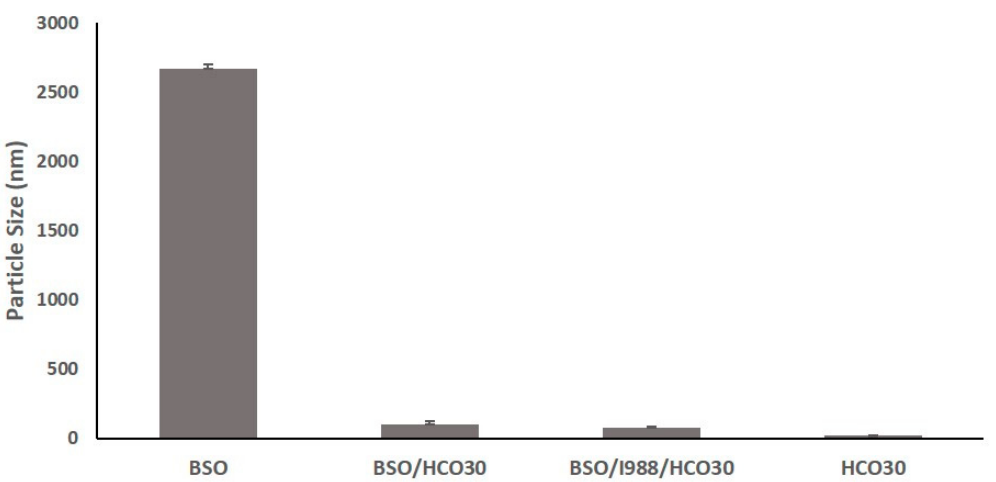
Figure 3. Effect of surfactant on the droplet size of the curcumin (CUR) bioactive formulations. The excipients were mixed as % ( w / w ). The formulations were represented by BSO (100%)-F1, BSO / HCO30 (50 / 50%)-F6, BSO / I988 / HCO30 (35 / 15 / 50)-F3, and HCO30-F7, respectively.